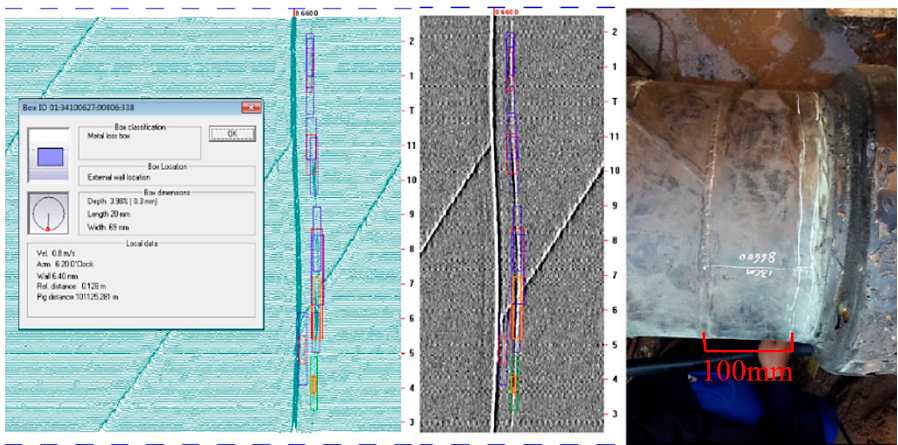
Figure 6. The metal loss signals caused by the grinding.